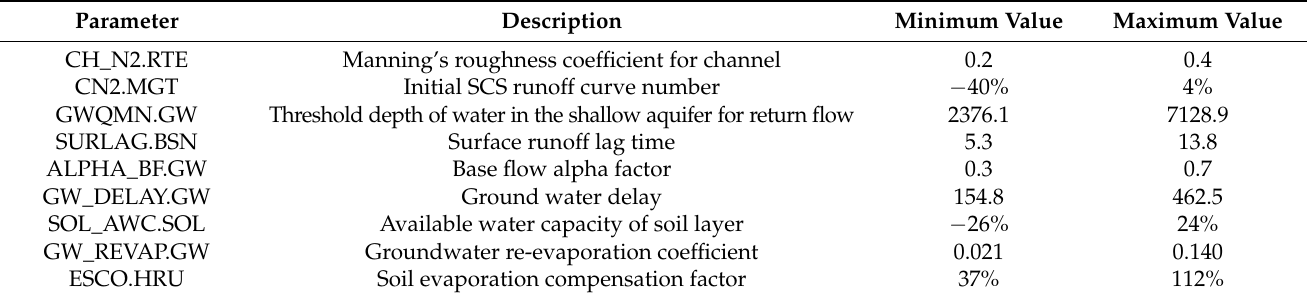
Table 2. SWAT parameters used for the calibration of Streamflow at Marigold, Sunflower, and Leland gauge stations.